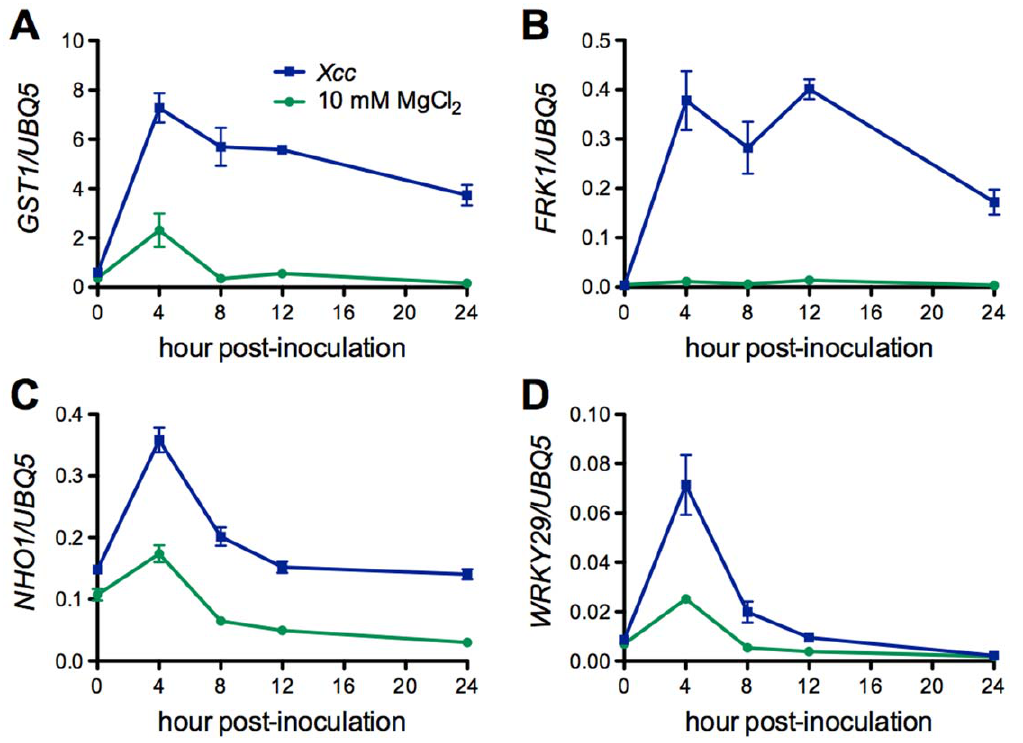
Figure 3. Xcc activates both ROS- and flg22-inducible early response genes in Arabidopsis. ( A ) Expression of GST1 . ( B ) Expression of FRK1 . ( C ) Expression of NHO1 . ( D ) Expression of WRKY29 . Four-week-old Col-0 plants were inoculated with Xcc (OD 600 =0.02) or mock-treated with 10 mM MgCl 2 . Leaf samples were collected at different time points (0, 4, 8, 12, and 24 hpi) for total RNA isolation and gene expression analysis using RT- qPCR. Expression levels were normalized against constitutively expressed UBQ5 . GST1 is a marker gene for the engagement of ROS-dependent defense. FRK1 , NHO1 , and WRKY29 are flg22-inducible genes. Data represent the mean of three biological replicates with standard deviation. The experiment was repeated twice with similar results.